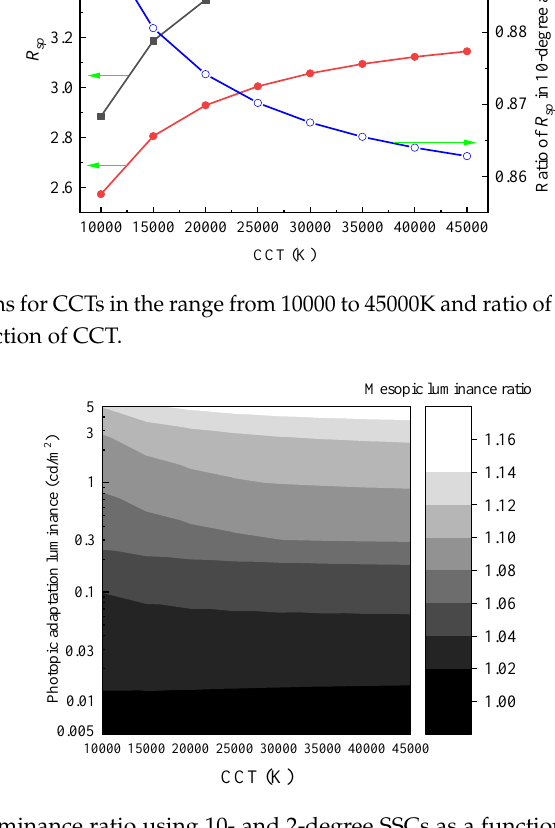
Figure 8. Mesopic luminance ratio using 10- and 2-degree SSCs as a function of CCT and photopic adaptation luminance.